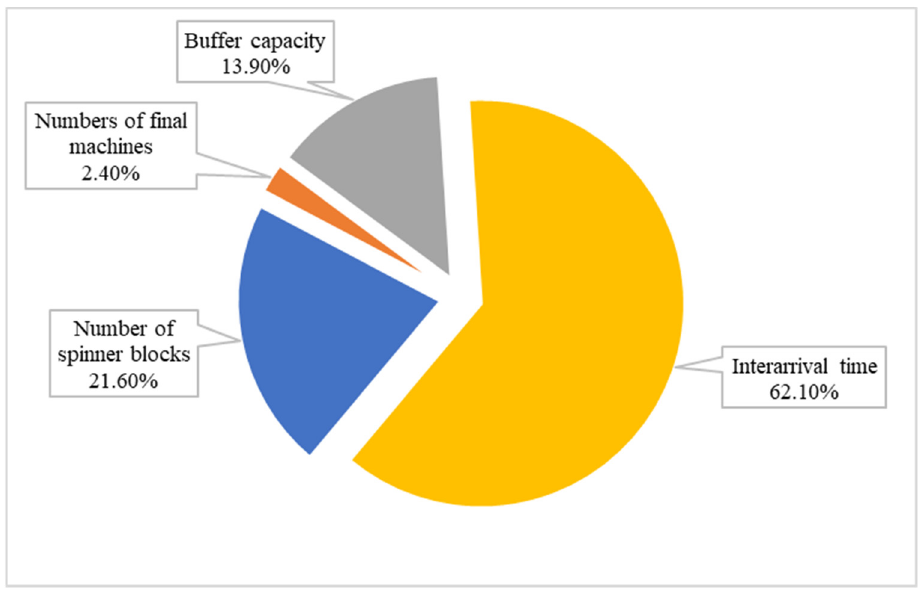
Figure 7. Contribution of each factor according to ANOVA table.